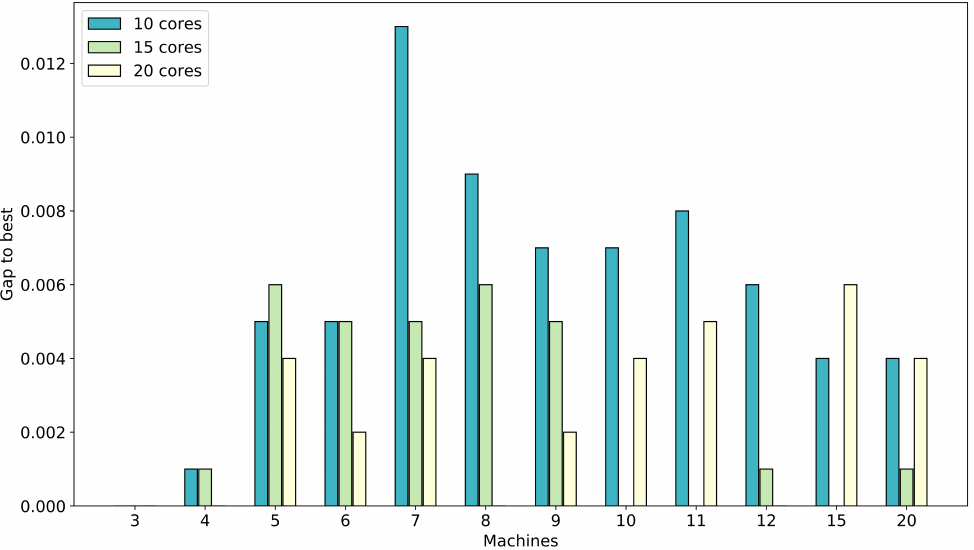
Figure 7. The performance of CMSA-ACO with 10, 15 and 20 cores. The results are averaged over instances with the same number of machines and show the gap to the best solution found by MS-ACO or